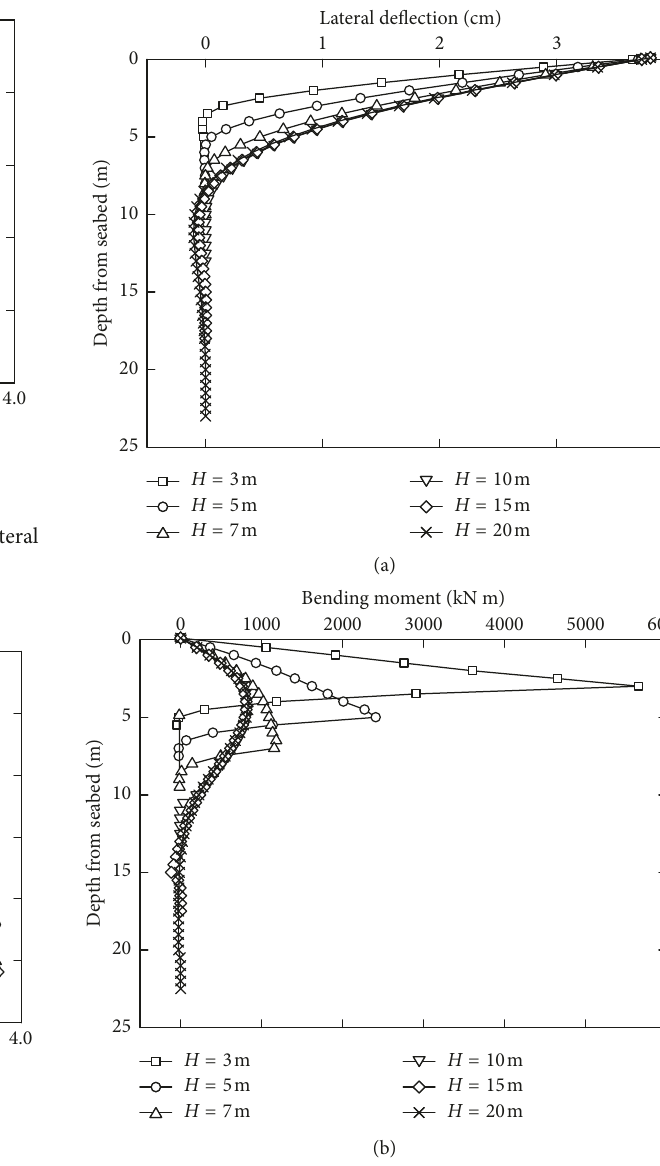
Figure 5: Effect of bedrock depth on the lateral load-displacement curve at the pile head.